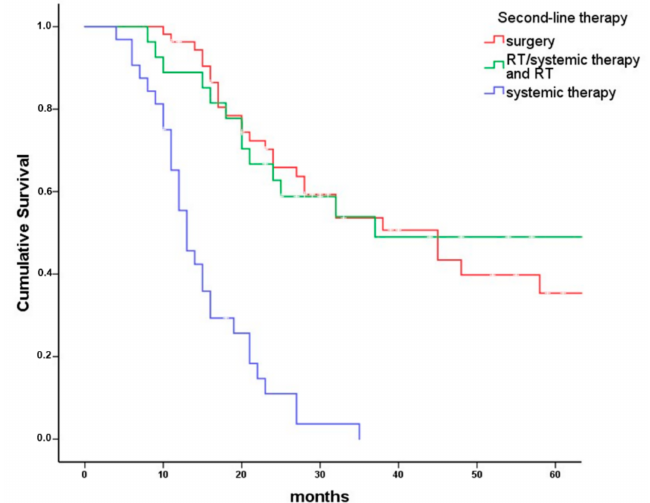
Figure 4. Overall survival of patients receiving second-line therapy for different treatment modalities. Kaplan–Meier plot comparing overall survival in 112 patients with persistent head and neck cancer grouped by second-line treatment modalities (surgery with or without RT or systemic therapy/RT n = 53, RT or systemic therapy/RT n = 27, systemic therapy only n = 32). Patients receiving surgery as second-line therapy had a median overall survival of 45 months (95% CI: 28–62 months). Patients receiving second-line RT with or without systemic therapy had a median overall survival of